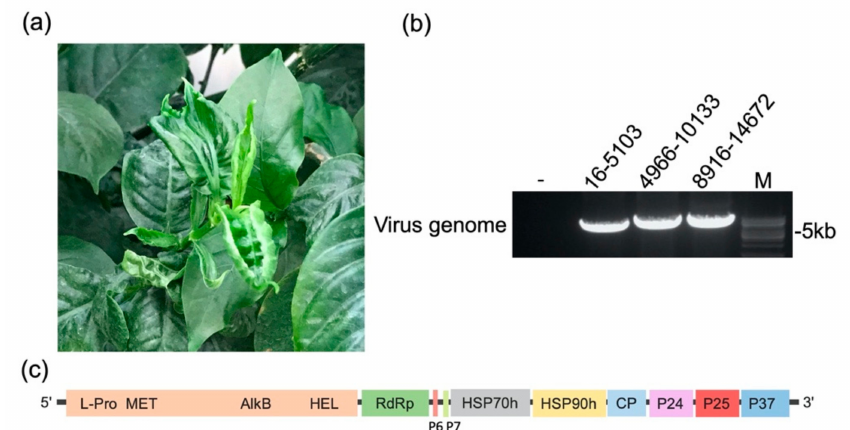
Figure 1. Features of firespike leafroll-associated virus. ( a ) Curly leaf and chlorosis symptoms of Firespike leafroll-associated virus (FLRaV) in infected firespike; ( b ) RT-PCR analysis of three sections of the FLRaV RNA genome on symptomatic firespike leaves—indicates RT-PCR reaction without primers; ( c ) Schematic representation of the genome organization of FLRaV. Boxes indicate the position of di ff erent open reading frames with their respective products, whereas black lines depict untranslated genomic regions. L-PRO, MET, AlkB, HEL: protease, methyltransferase, AlkB and helicase domains of the replicase polyprotein; RdRp: RNA-depenent RNA polymerase; p6: 6 kDa protein; p7: 5 kDa